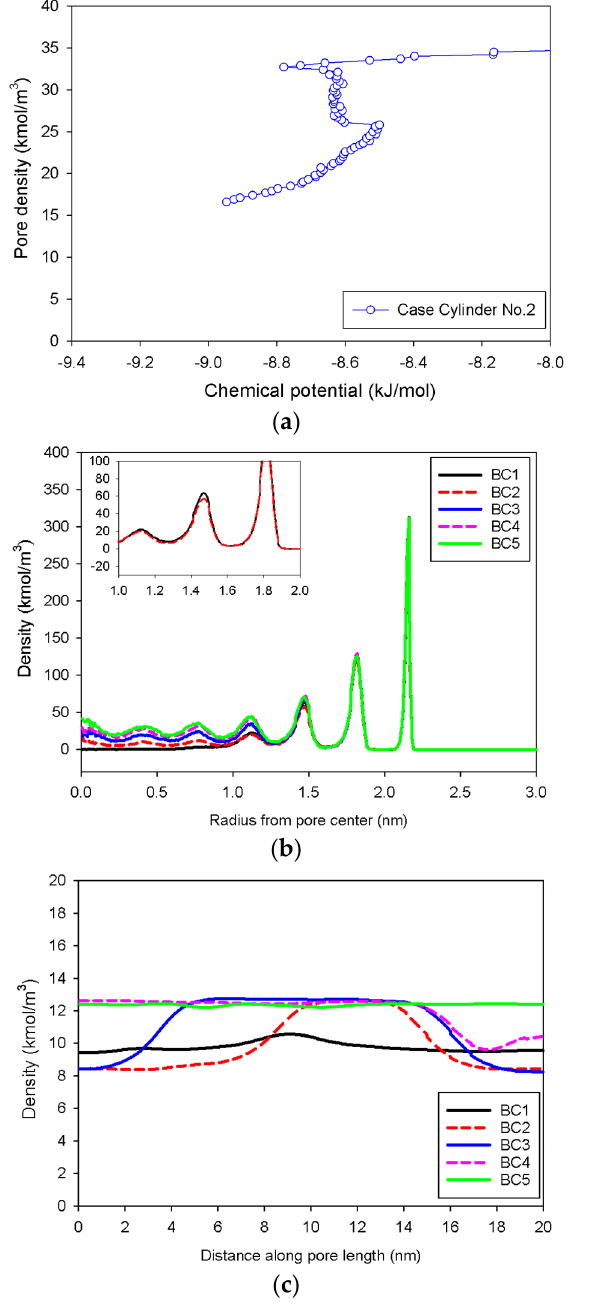
Figure 9. ( a ) Nitrogen adsorption isotherm in the infinite cylindrical pore of 5 nm in diameter at 77 K for Cylinder No.2, its local density distributions ( b ) across pore radius and ( c ) along pore length, and ( d ) molecular snapshots of nitrogen on each point.